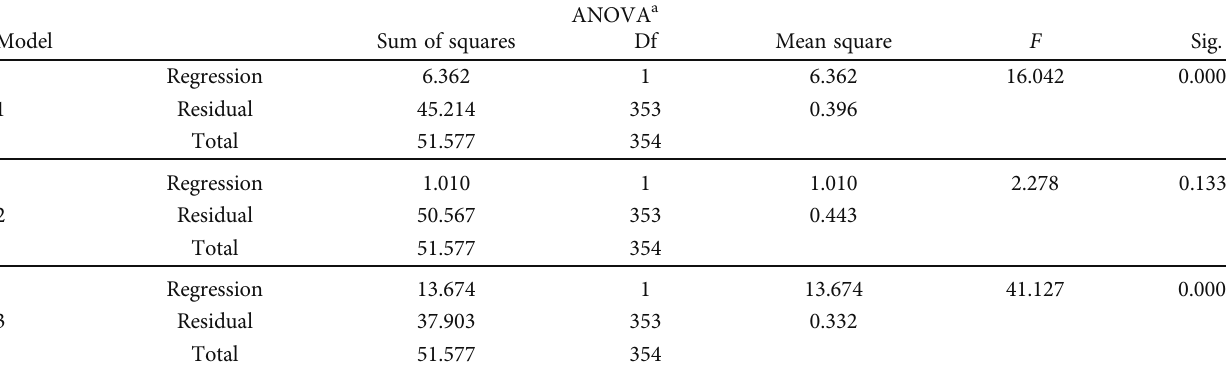
Table 5: Variation analysis of the variables (ANOVA).